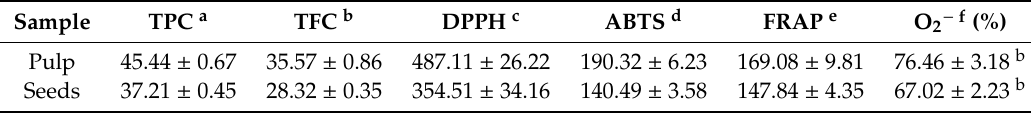
Table 2. Total phenolic contents, total flavonoid contents, and antioxidant activities of G. sphacelata. Sample TPC